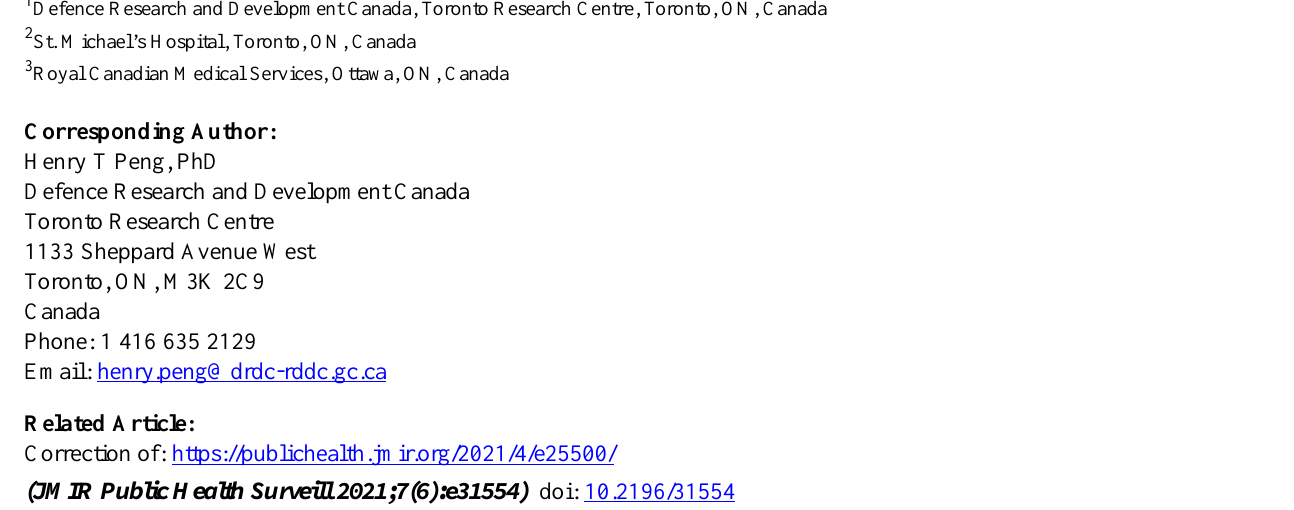
row “Al Helali et